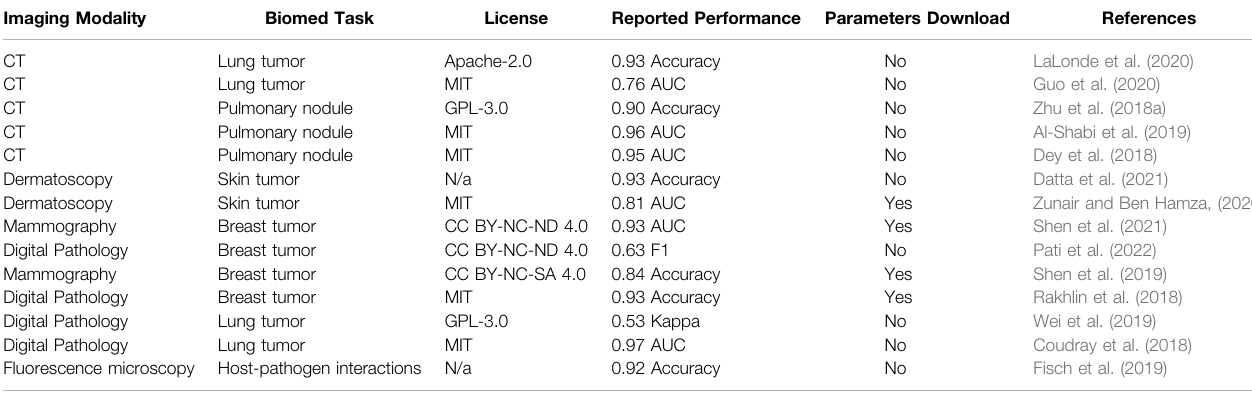
TABLE 1 | Biomedical Image Classi fi cation Models. Here, AUC is Area under curve, CT is computed tomography. Imaging Modality